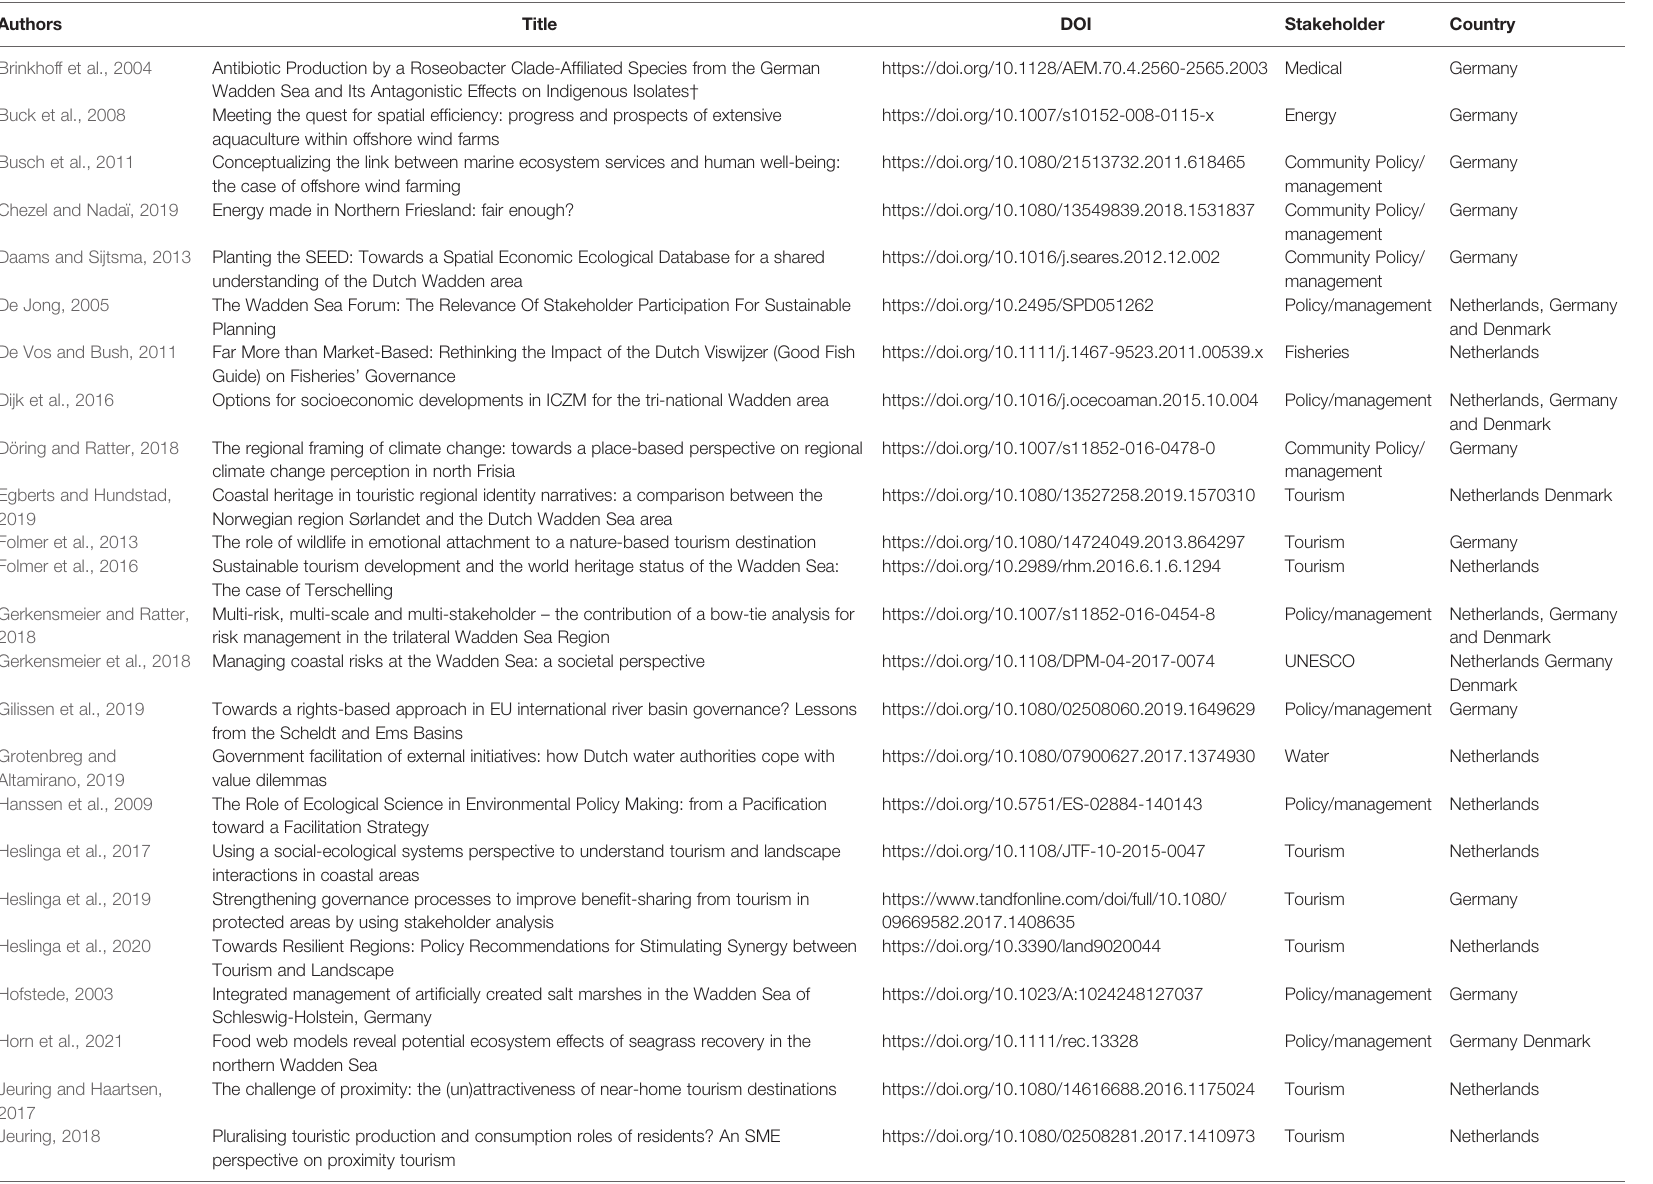
TABLE 2 | Final consortium of papers selected for review with indication of the the primary stakeholder targeted and country were stakeholders reside. Authors Title DOI